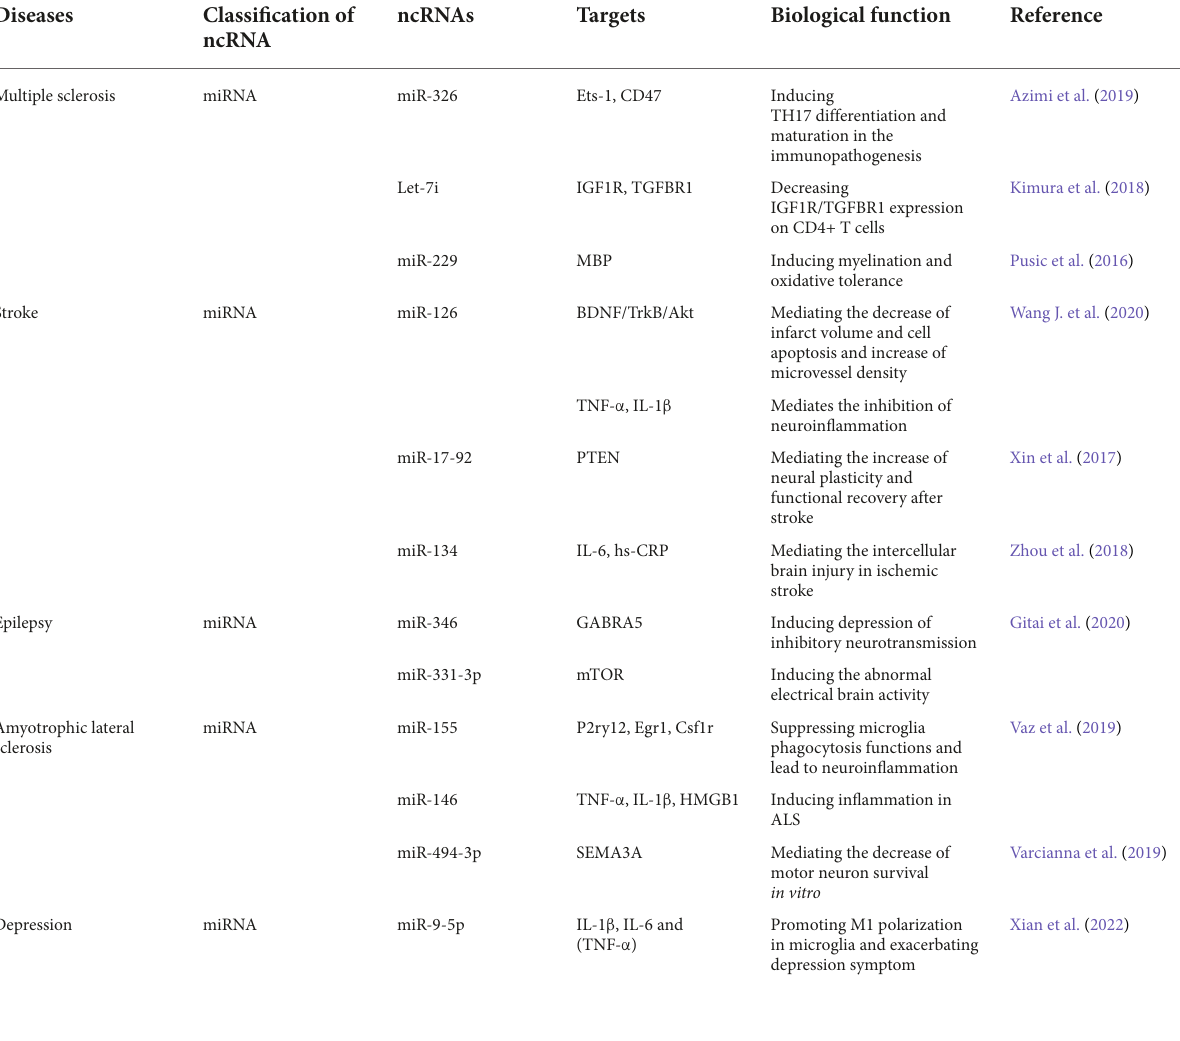
TABLE 3 The biological functions of exosomal ncRNAs in MS, stroke, epilepsy, ASL, and